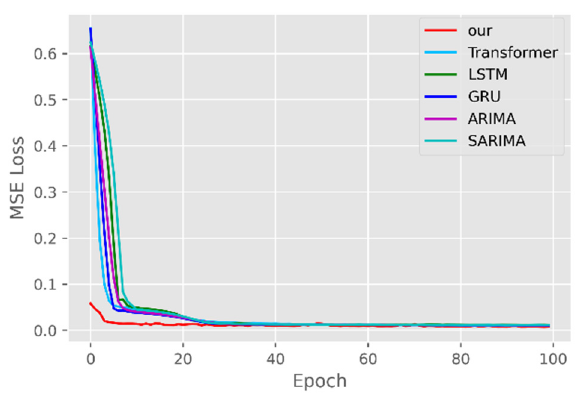
Figure 9. Comparison of training loss for NY vaccines.